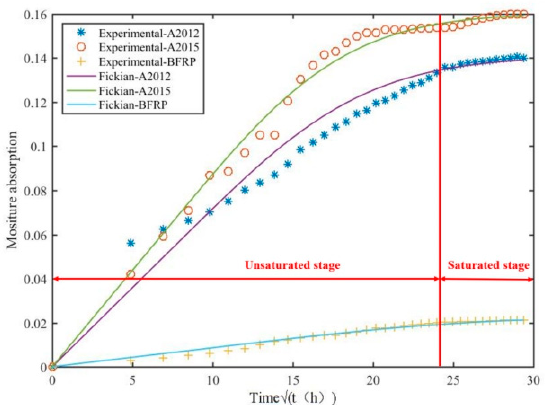
Figure 7. Experimental and analytical moisture absorption curves of the adhesive bulk specimen. The entire moisture absorption process is divided into two stages: the unsaturated stage and the saturated stage. In the first stage, the dumbbell-shaped specimen has a faster moisture absorption rate, but the speed gradually decreases, and the slope of the curve decreases with time. In the second stage, the moisture absorption is saturated, the saturated water absorption content of A2012 adhesive is about 14.05%, and the saturated water absorption content of A2015 adhesive is about 16.03%. Generally speaking, part of the water absorbed in the first stage enters the adhesive as free water, occupying a certain space, mainly filling pores and cavities, and supplemented by the reaction of adsorbed water molecules with some hydrophilic functional groups. This leads to plasticization of the adhesive [18]. Careful observation of the curve shows that there is a certain difference between the curve simulated by Fick’s law in the first stage and the actual experimental data. It may be due to two reasons. One is the limitation of Fick’s law itself. Fick’s law only assumes that water diffuses into the material and stays in the free volume, while ignoring the reaction of water molecules with certain functional groups in the material [34]. Second, the experimental data are generally accurate to four decimal places. Such accurate data very easily cause certain errors in the measurement process due to irregular measurement. At the same time, air humidity, room temperature fluctuations and airflow speed also cause errors in the measurement data.